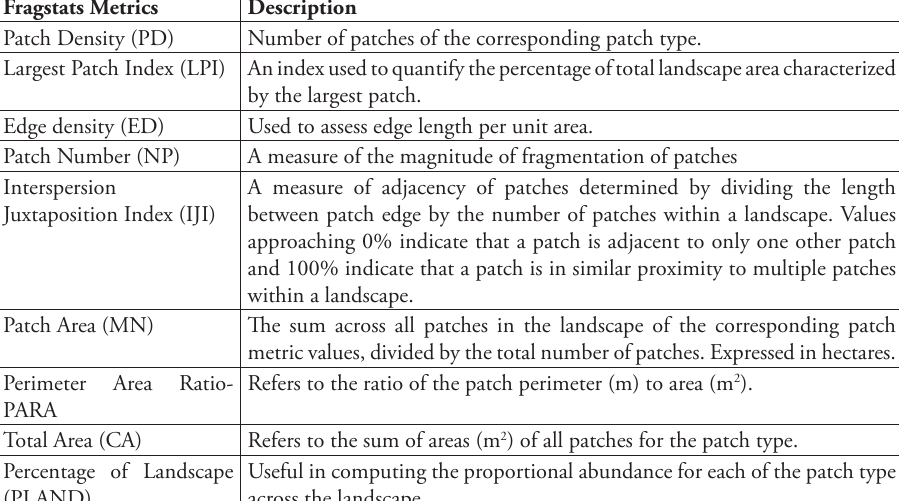
Table 1. Fragmentation Indices used in the current study. Fragstats